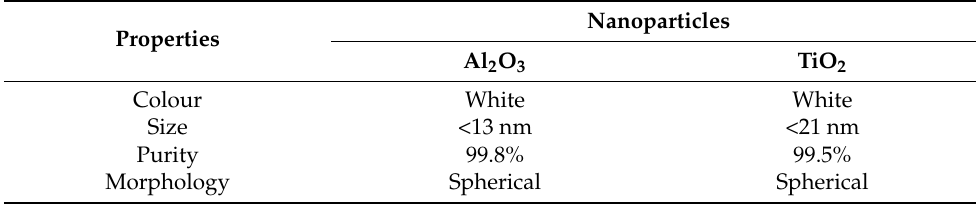
Table 1. Physical properties of Al 2 O 3 and TiO 2 nanoparticles